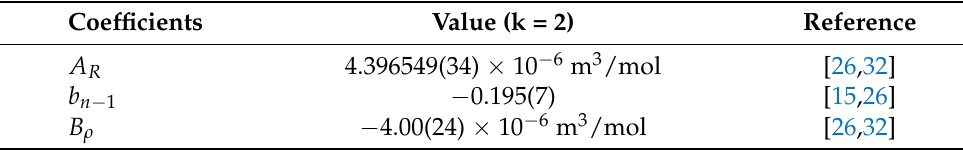
Table 1. Gas coefficients for N 2 at 302.91 K and 1550.14